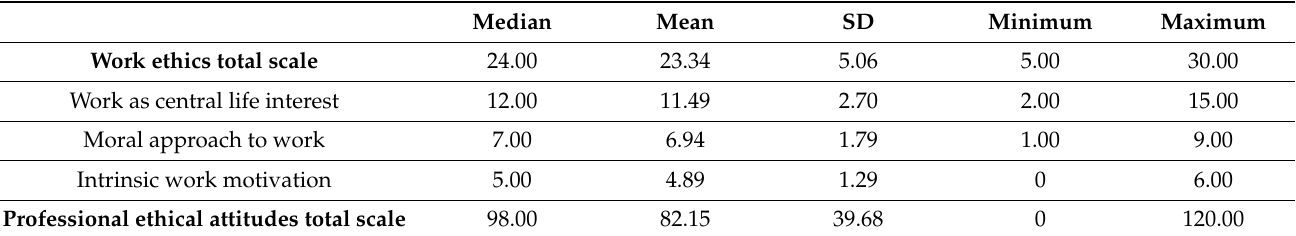
Table 2. Description of the work ethics scale and professional ethical scale in the study.